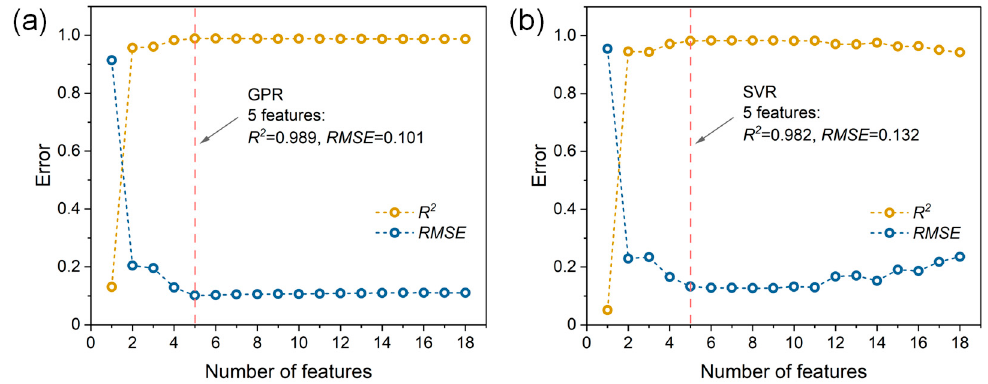
Figure 5. Variations in R 2 and RMSE as a function of the number of input features. ( a ) GPR model and ( b ) SVR model.